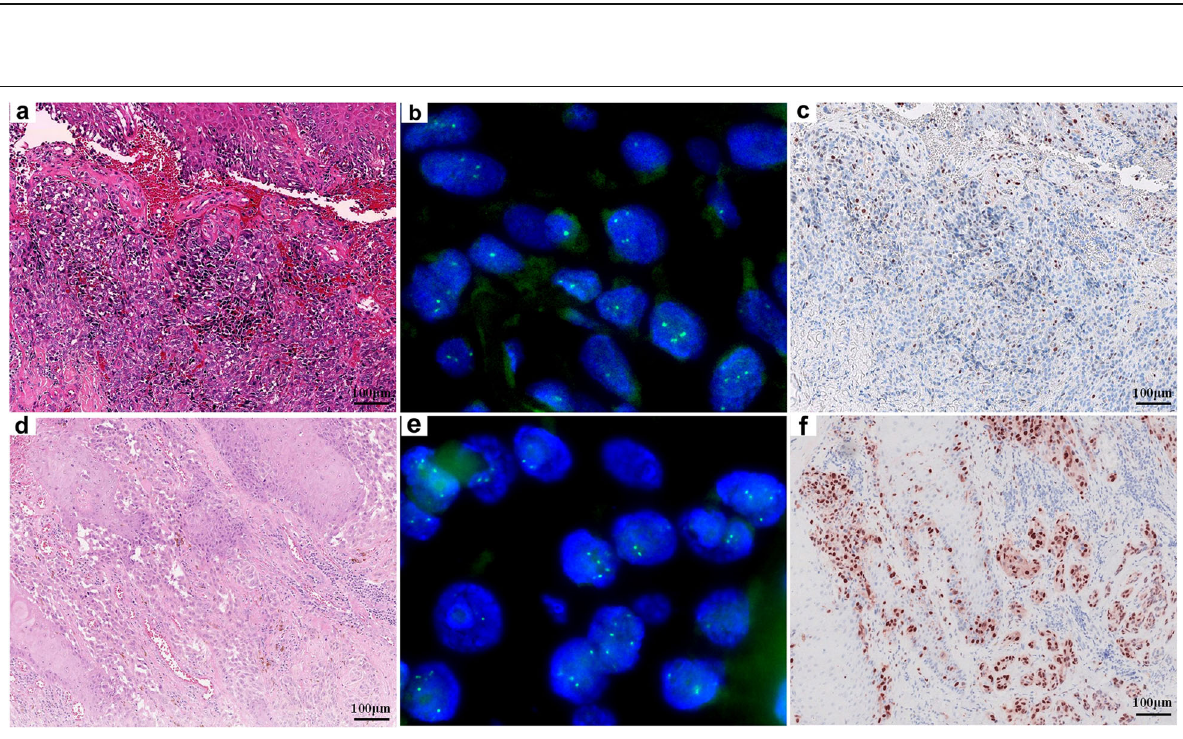
Fig. 3 Acral melanomas with low-level CCND1 copy number increase may show either low- or high-expression of cyclin D1 protein. An acral melanoma on the heel of a 74-year-old female with low-level CCND1 gene copy number increase shows low expression of cyclin D1 protein ( a , HE 100x; b , CCND1 copy number by FISH; c , cyclin D1 expression by IHC). An acral melanoma on the sole of a 53-year-old male with low-level CCND1 copy number increase shows high expression of cyclin D1 ( d , HE 100x; e , CCND1 copy number by FISH; f, cyclin D1 expression by